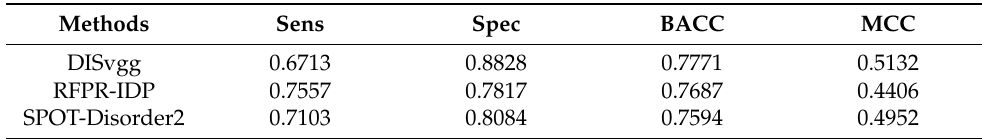
Table 1. Performance Parameters on Test Dataset